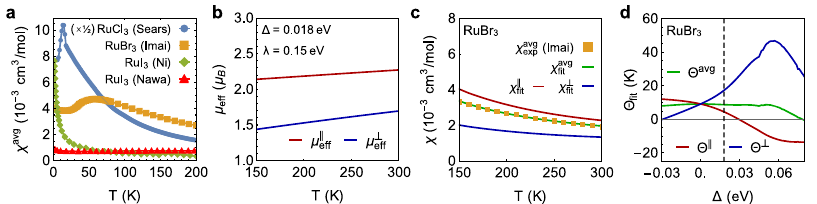
Fig. 2 Magnetic susceptibility and modi fi ed Curie – Weiss fi t. a Experimental direction-averaged RuX 3 susceptibility data, extracted from plots in the following references and labeled by respective fi rst-author names: RuCl 332 , RuBr 325 , RuI 327 , RuI 326 . Note that the RuCl 3 curve is scaled by 1 . b Calculated temperature-dependent effective moment μ eff ( T ) for Δ = 0.018 eV and SOC λ = 0.15 eV. c Modi fi ed Curie – Weiss fi t of 2 RuBr 3 data, taking into account such μ eff ( T ). d Dependence of best- fi t Weiss constants on assumed Δ . The vertical dashed line indicates Δ = 0.018